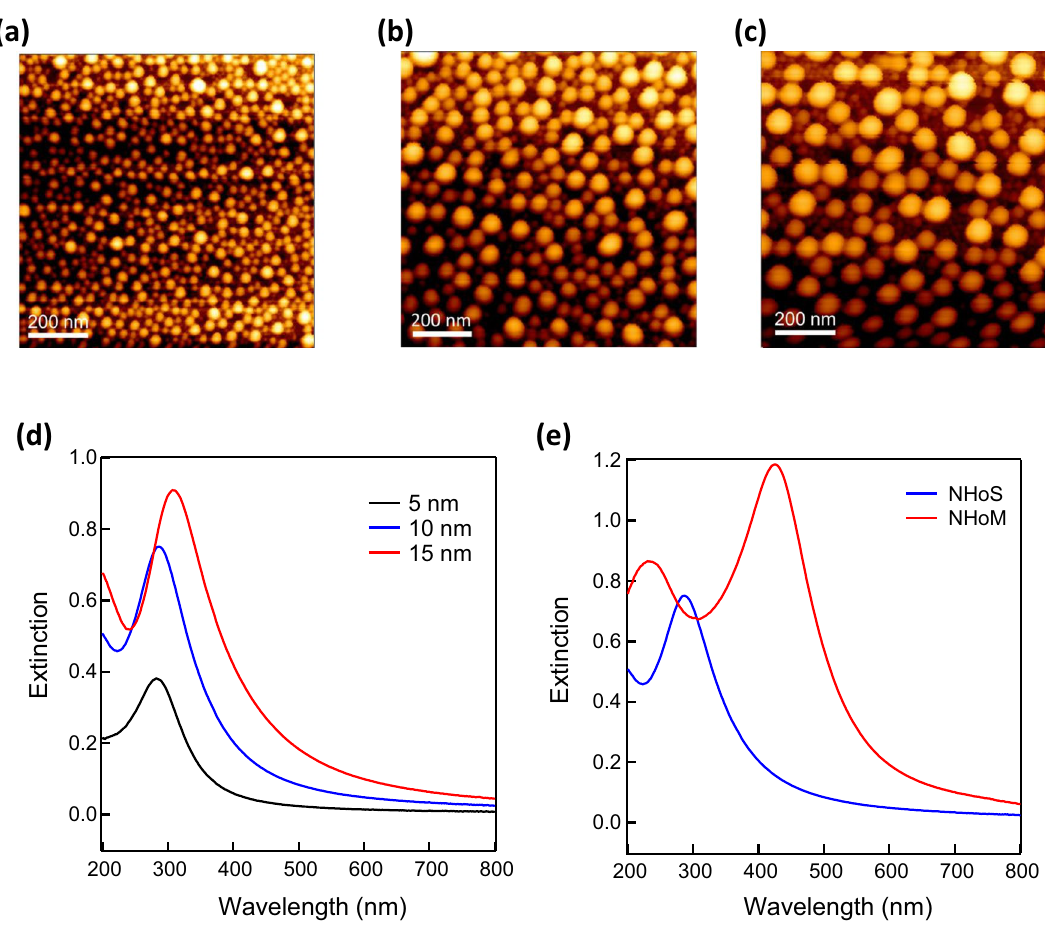
Figure 7. AFM images and extinction spectra of the fabricated Ga nanostructures. AFM images of ( a ) 5 nm, ( b ) 10 nm, and ( c ) 15 nm Ga after annealing. ( d ) Experimental extinction spectra of 5, 10, and 15 nm Ga after annealing. ( e ) Experimental extinction spectra of 10 nm Ga after annealing and Ga NHoM structure. The Al 2 O 3 spacer layer thickness was 10